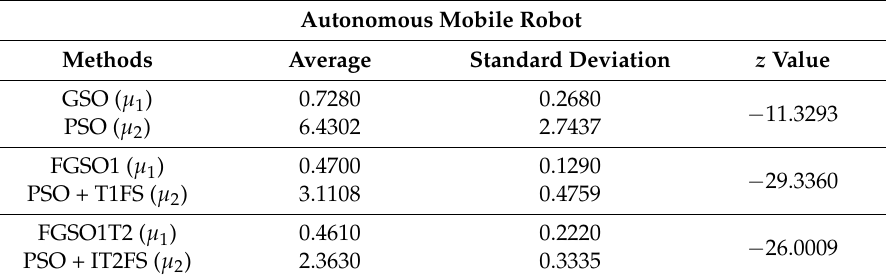
Table 8. Results for the z test between the proposal and PSO [4] with